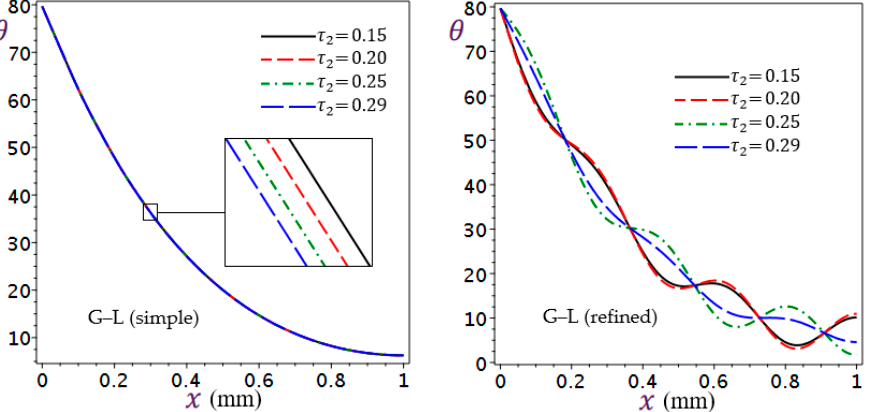
Figure 14. Effect of second relaxation time τ 2 of G–L theory on temperature θ .